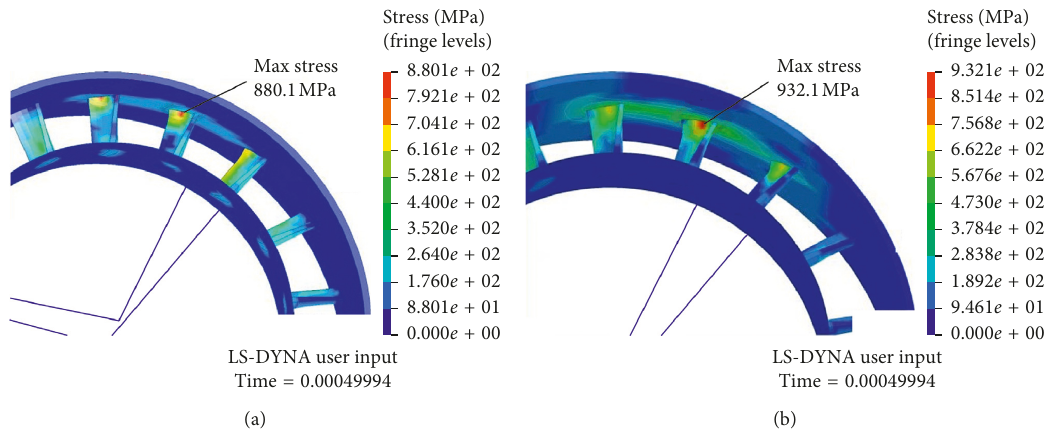
Figure 23: Distribution of Von Mises stress with lower Young’s modulus. (a) Initial Young’s modulus. (b) 50% Young’s